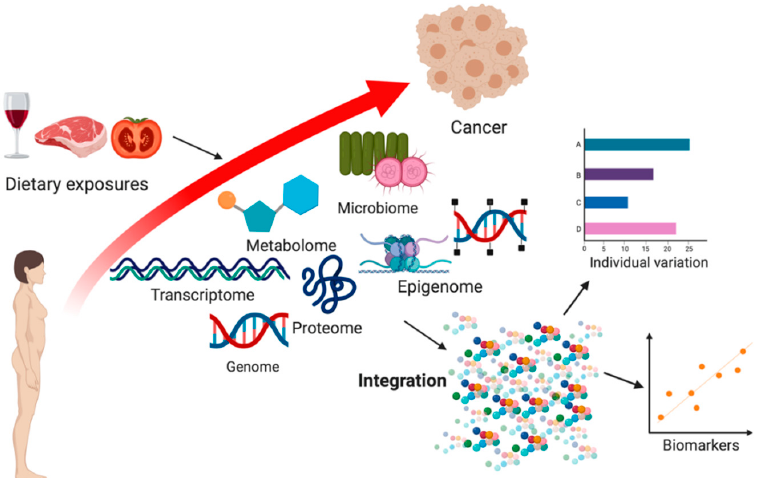
Figure 1. Systems biology approach to studying the biological processes linking diet and cancer. Through integration of omics approaches spanning the genome, epigenome, transcriptome, metabolome, proteome and microbiome, biomarkers of dietary exposures and the variation in the biological response to diet may be identified. Created with Biorender.com.